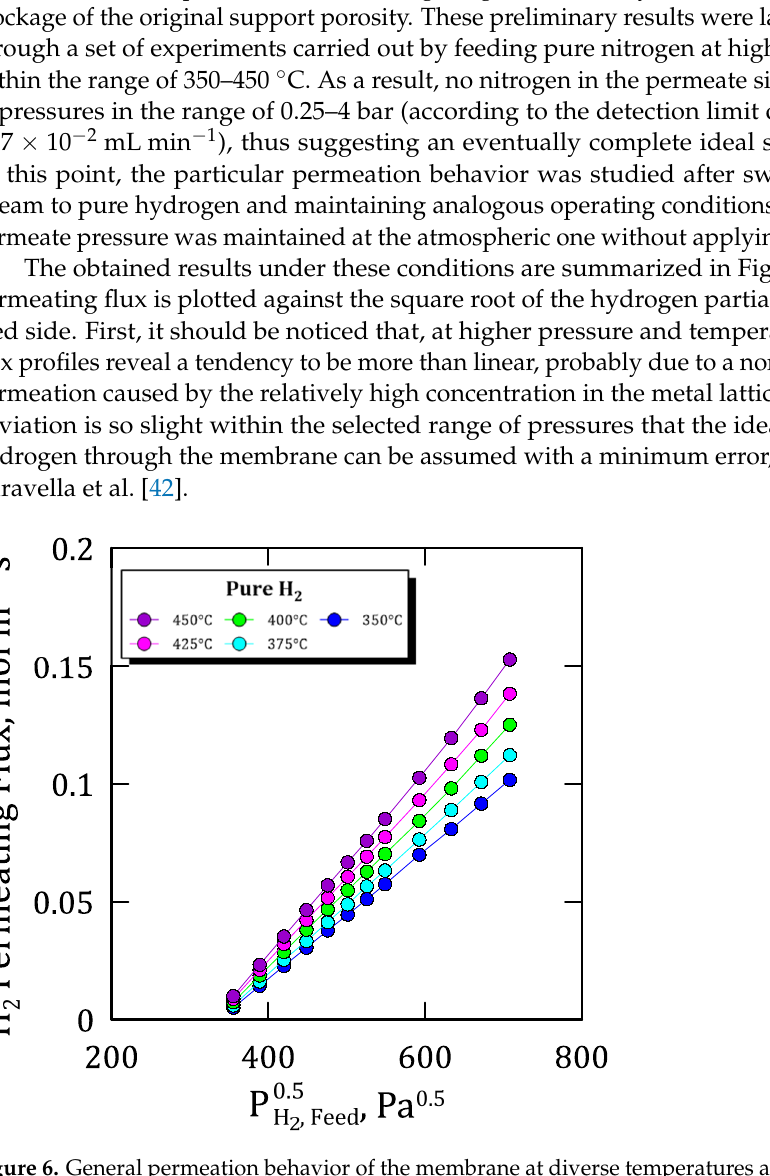
Figure 6. General permeation behavior of the membrane at diverse temperatures and pressures while feeding pure hydrogen.